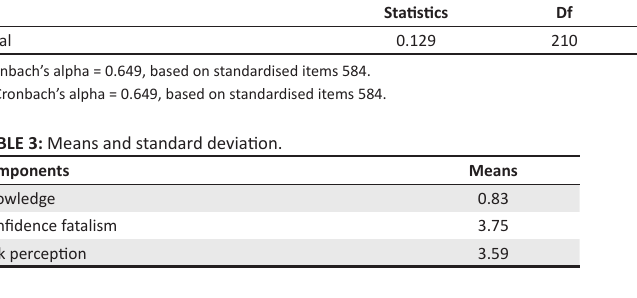
TABLE 2: Test results of reliability and normality. Reliability of statistics